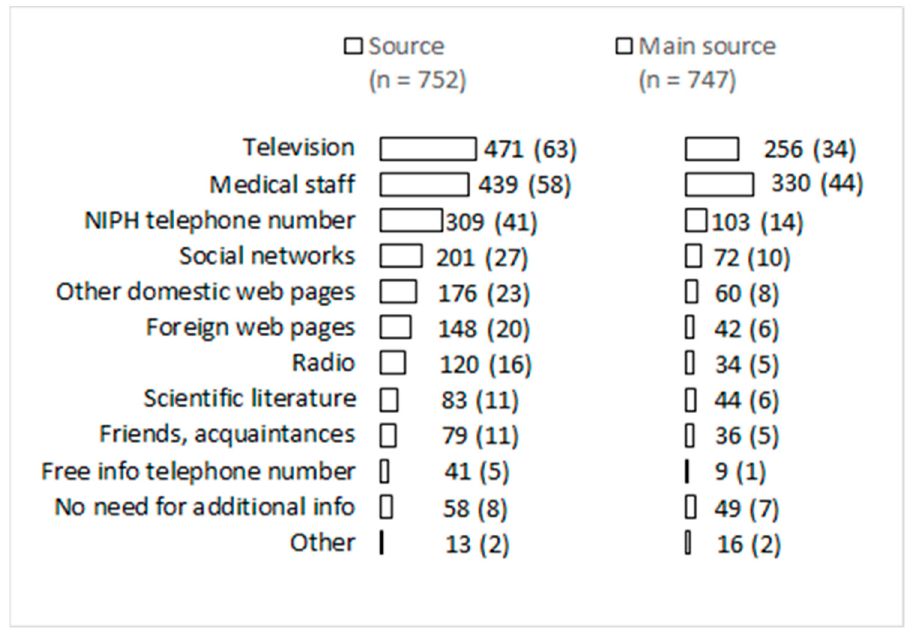
Figure 3. Source of information about COVID-19 for SARS-CoV-2 notified cases in the first pandemic wave; No (%) (NIPH = National Institute of Public Health). Table 5. Association between patient characteristics, support and source of information and the presence of negative feelings during SARS-CoV-2 acute infection in the first